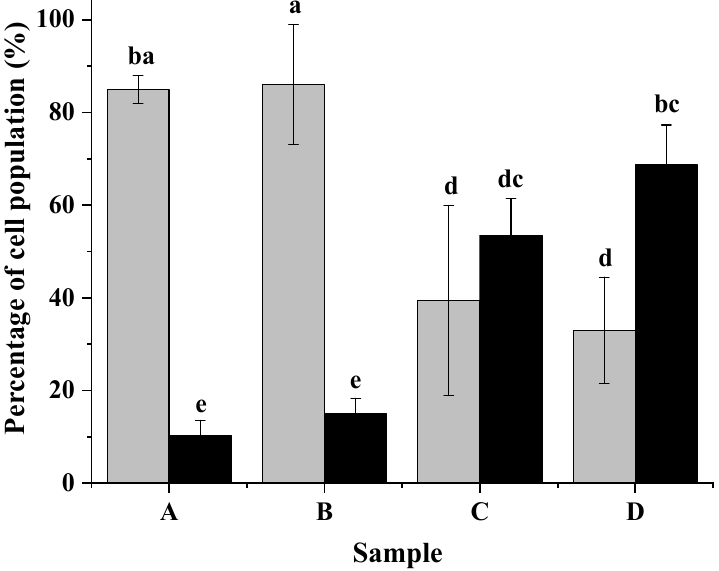
Figure 3. Flow cytometric quantification of membrane lipid oxidation in S. Typhimurium ATCC13311 due to vacuum drying for 18–20 h (A), followed by equilibration to 0.75 a w for 20–24 h (B); and treatment of dried and equilibrated S. Typhimurium with 365 nm (C) and 395 nm (D) LEDs using C11-BODIPY 581/591 dye as a fluorescent indicator. The stained and oxidized (black bars) and stained and unoxidized cells (gray bars) are shown as the percentage of cell populations. Treatments with 365 and 395 nm light pulses of low-a w S. Typhimurium ATCC13311 were performed at 80% power level and at 4 cm from the LED head with ~217 J/cm 2 dose corresponding to treatment times of 60 and 12 min, respectively. Results are represented as means ± standard deviation of three independent replicates. Values with different letters differ significantly ( p < 0.05).